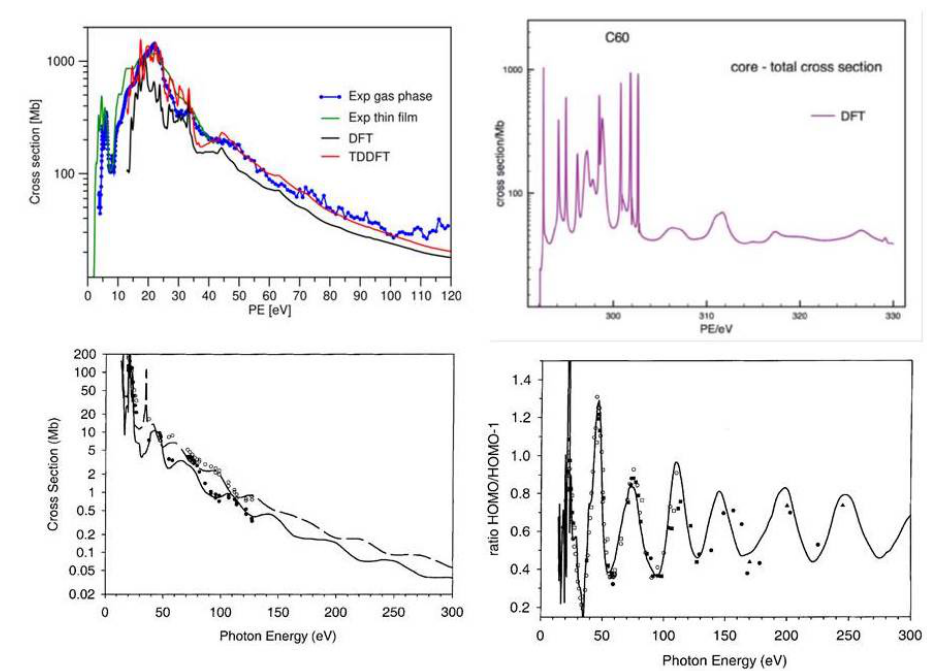
Figure 2. C 60 photoionization. Upper left: Total DFT and TDDFT cross section, from Ref. [36] with permission. Upper right: High resolution DFT core cross section [37]. Lower left: HOMO and HOMO-1 cross sections; lower right HOMO/HOMO-1 cross section ratio (circles are experimental data), from Ref. [38] with